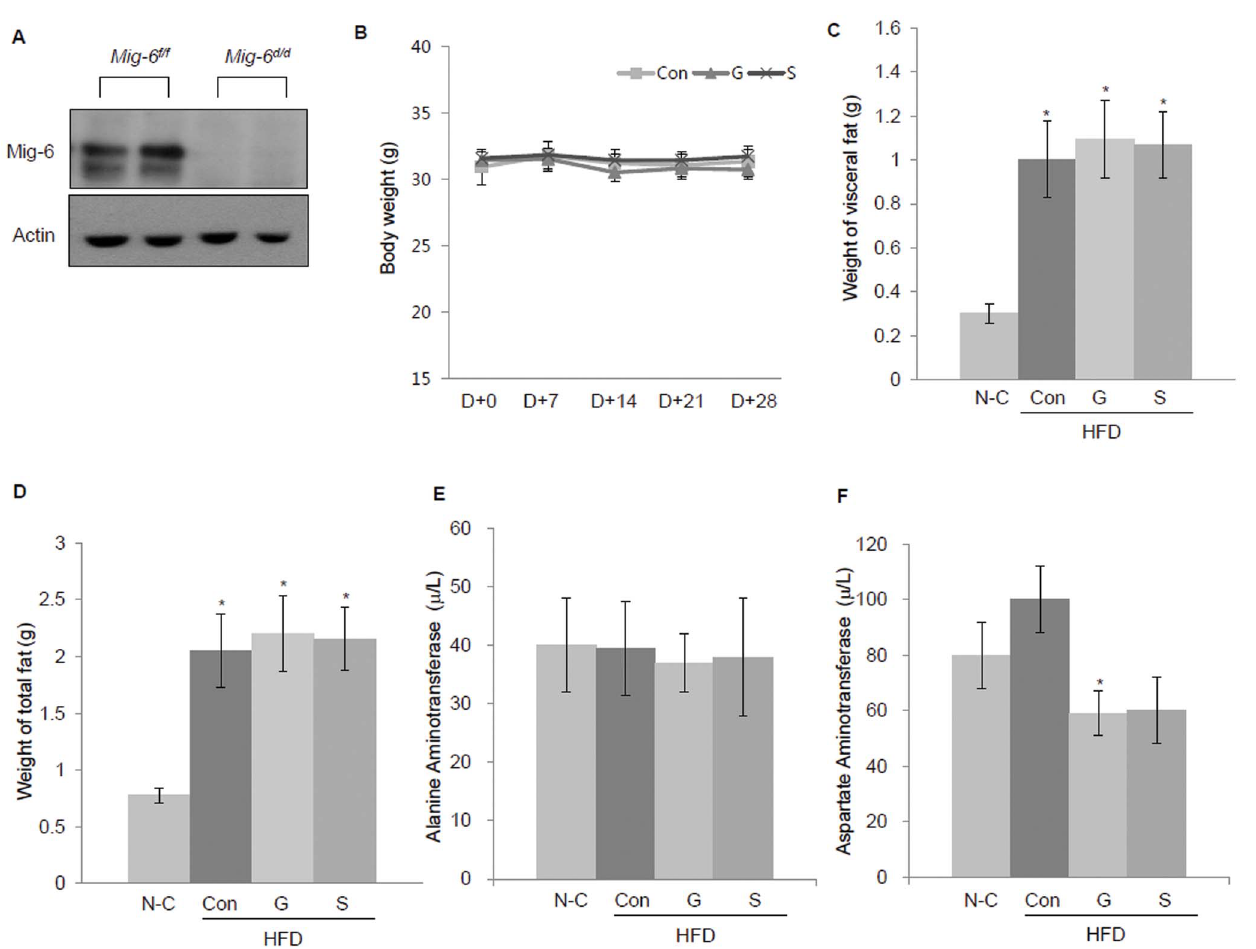
Fig. 1. Generation of conditional ablation of Mig-6 in the liver and impact of gefitinib on adipose tissue and liver enzymes in Mig-6 d/d mice. (A) Western blot analysis of Mig-6 in the liver of Mig-6 f/f and Mig-6 d/d mice. Liver tissue from Mig-6 f/f and Mig-6 d/d mice were lysed and equal amounts of protein were subjected to SDS-PAGE and Western blot analysis for Mig-6. (B) Changes of body weight during the course of standard diet or high fat-diet with or without gefitinib or statin. (C) Changes in visceral fat and (D) total fat weight after 6 weeks of gefitinib and statin treatment. (E) Relative changes in plasma alanine aminotransferase and (F) aspartate aminotransferase after 6 weeks of gefitinib and statin treatment. Values represent the means ¡ SEM. * P , 0.05 relative to the normal control. N-C, normal control; HFD, high-fat diet; Con, control; G, gefitinib; S, statin.